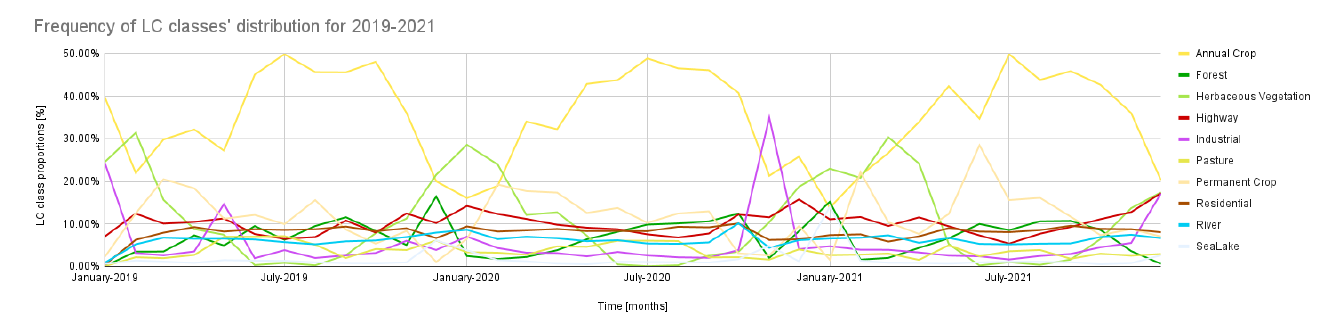
Figure 8. Timeline of LC frequencies for the indicator classes.